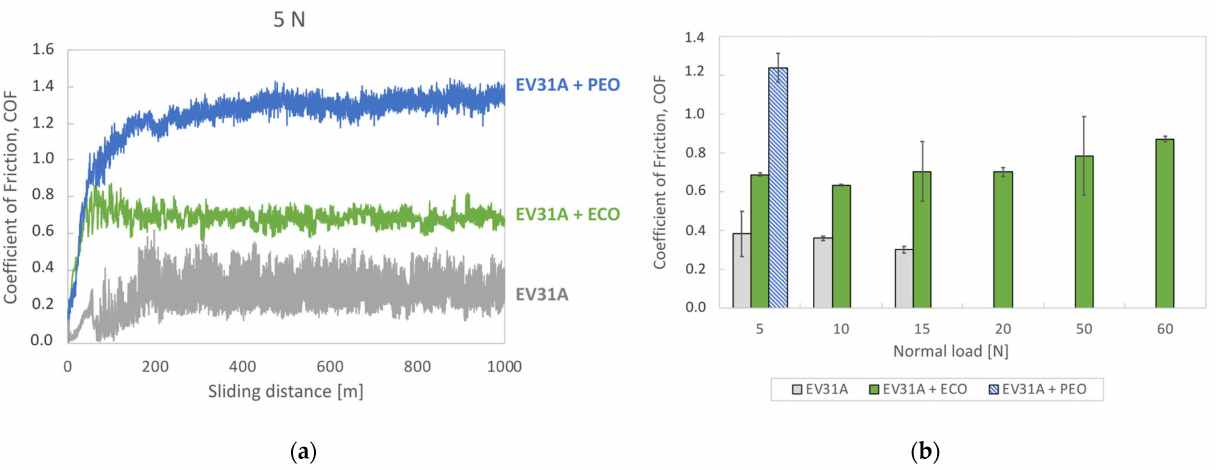
Figure 7. Dry sliding tests (vs. 100Cr6 steel, 1000 m, 0.3 m/s): dynamic COF as a function of sliding distance for untreated and ECO-treated EV31A at 5 N, compared to PEO-treated EV31A [28] ( a ); average values of steady-state coefficient of friction for all tested conditions (data for PEO-treated EV31A at 5 N from [28]) ( b